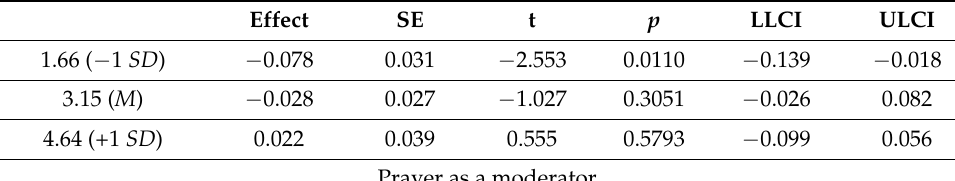
Table 7. Conditional effects of tendency to revenge at values of moderator.